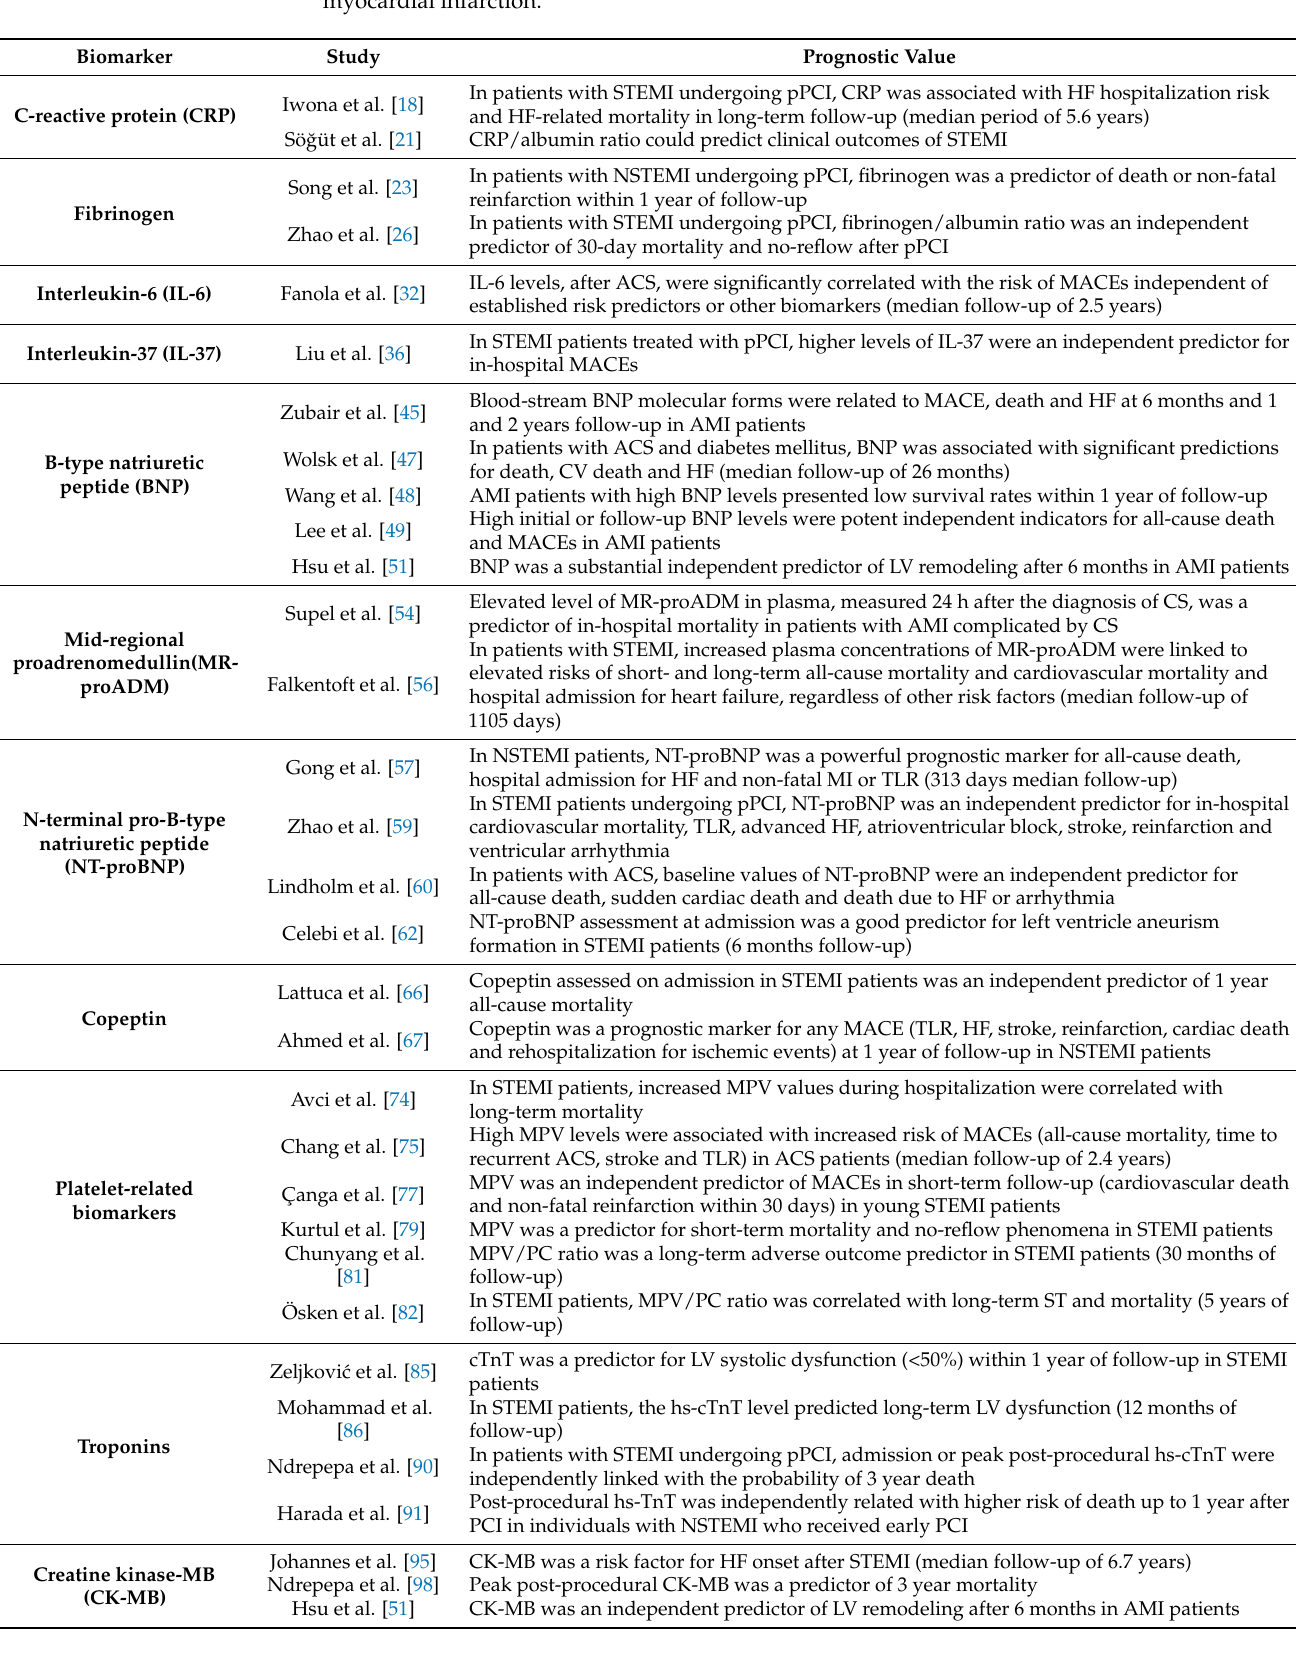
Table 1. Studies investigating known and possible prognostic biomarkers in patients with acute myocardial